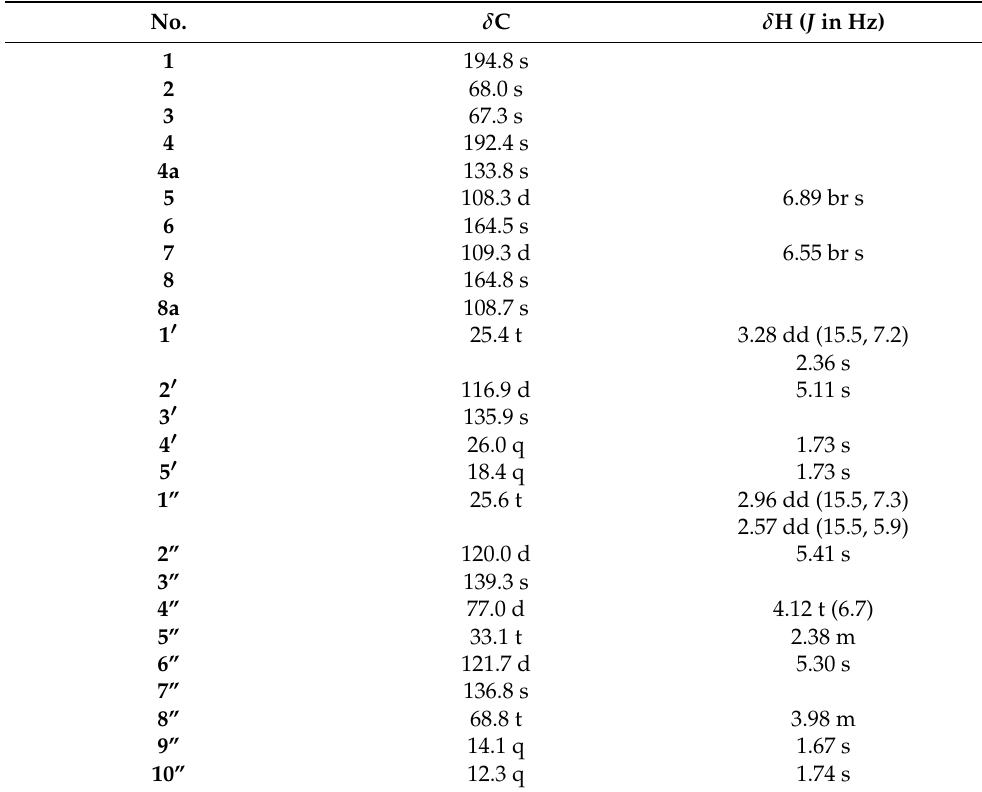
Table 2. 1 H (600 MHz) and 13 C (175 MHz) NMR data of compound 2 in CDCl 3